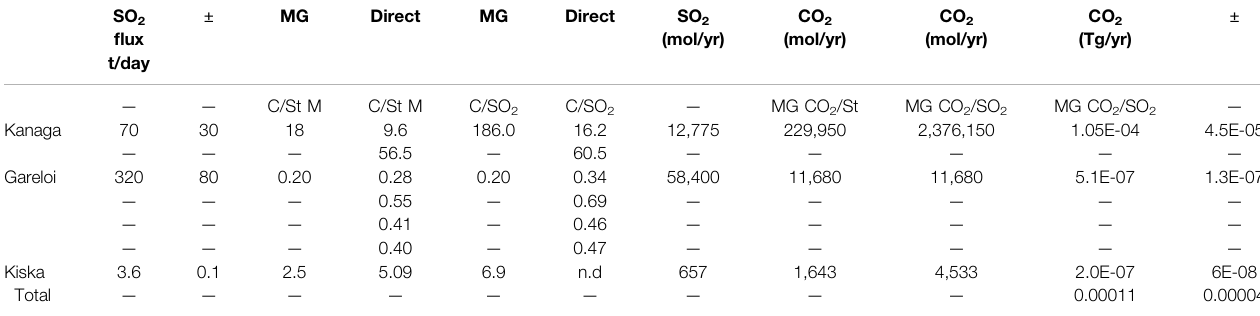
TABLE 4 | SO 2 fl uxes measured by miniDOAS and calculated CO2 fl uxes using indicated gas ratios from direct samples or MultiGAS. SO 2 fl ux